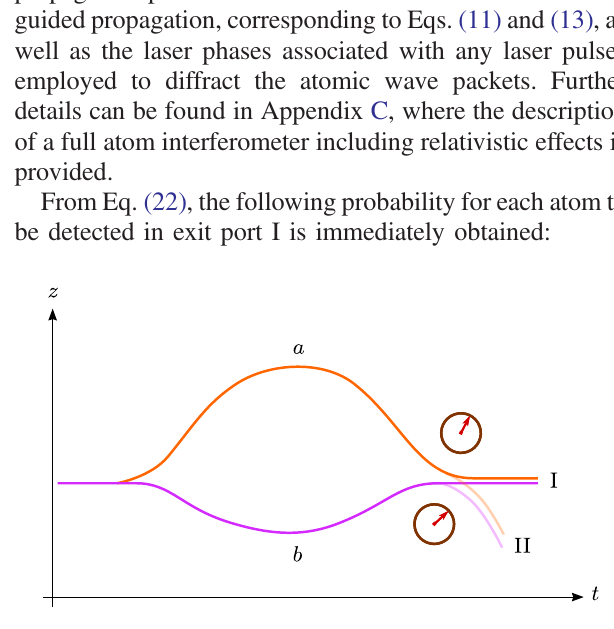
FIG. 3. Central trajectories for the interfering wave packets of a quantum clock at exit port I. Nontrivial effects arise when the proper times along the two interferometer branches ( a and b ) differ. Analogous results hold for exit port